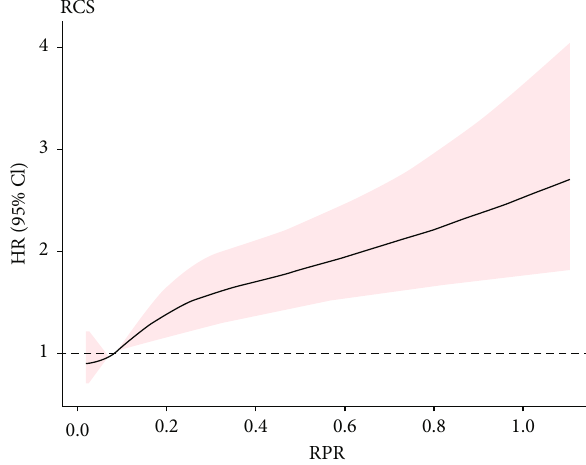
Figure 1: The relationship between RPR levels and 28-d mortality in patients with sepsis was plotted using multivariable adjusted restricted cubic splines. There was a nonlinear relationship between RPR and 28-d mortality, showing a trend of rapid fi rst and then gradually increasing, that is, the higher the RPR level, the higher the mortality risk. The range area represents a 95% con fi dence interval. HR: hazard ratio; CI: con fi dence interval; RPR: red cell distribution width to platelet